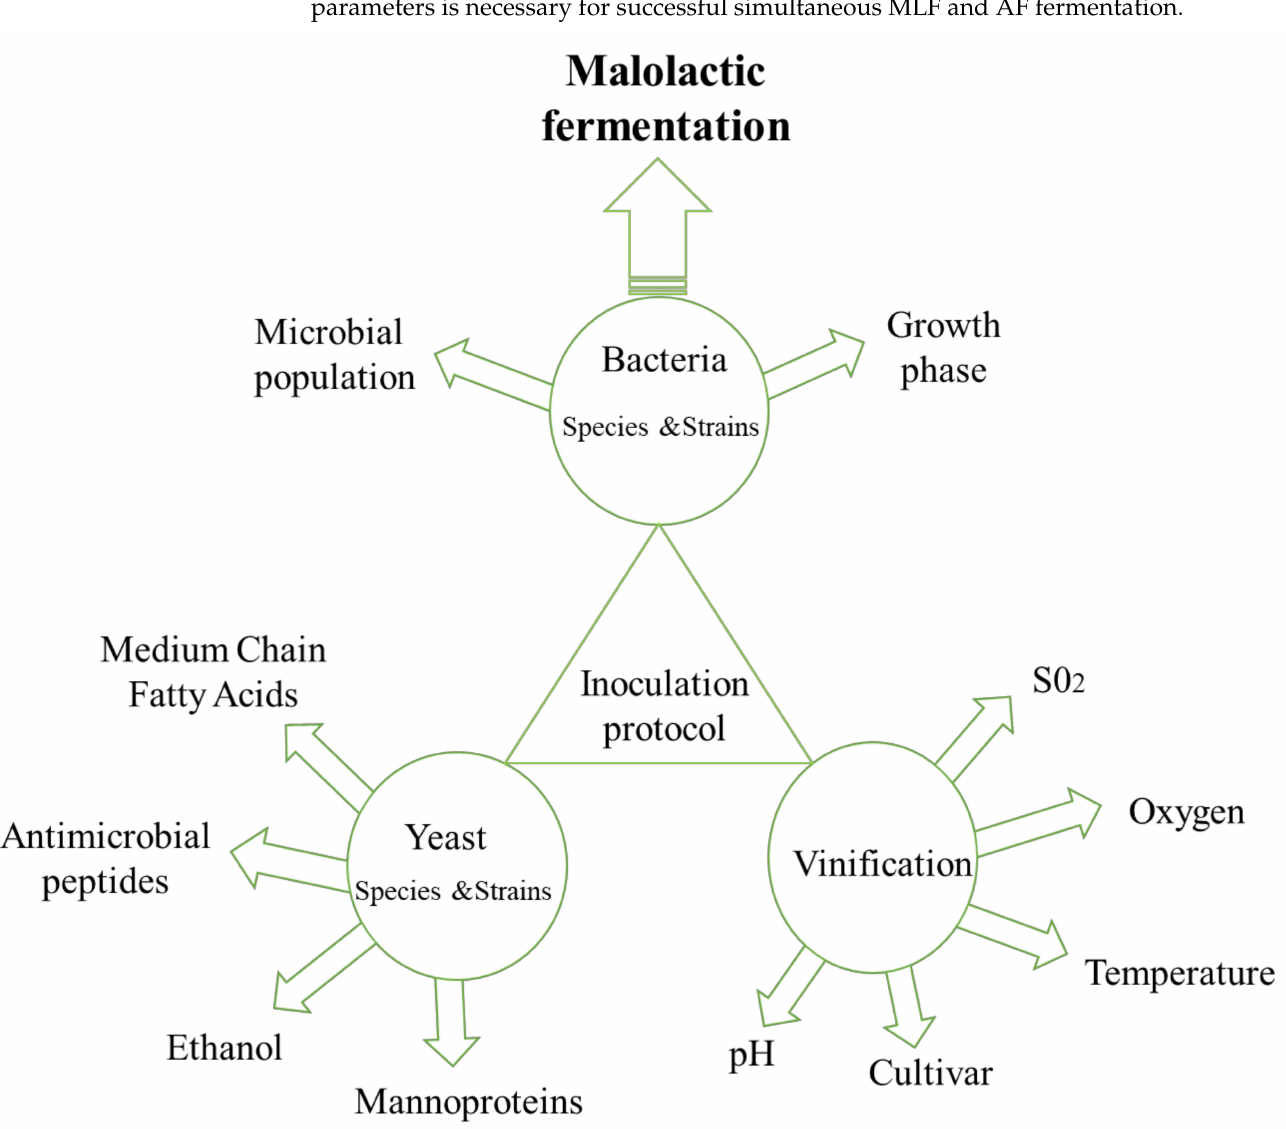
Figure 2. Biotic and abiotic factors affecting